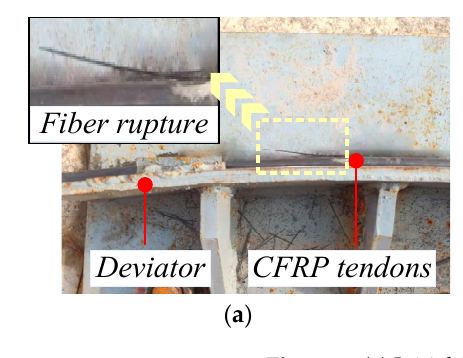
Figure 9. ( a ) Initial failure test, ( b ) Ultimate failure test. Failure in CFRP tendon tests. The load-time curve for cases B-20 and BF-20 under single bending showed that two peaks existed on the curve, points a and b (Figure 10), representing the axial force at the tensile end, which corresponded to the initial and the ultimate failure states (Figure 9a,b, respectively). In addition, there was a difference between the axial force curves of the tensioned and fixed ends, and the BF-20 working condition demonstrated a larger gap than the B-20 working condition. This was because BF-20 had no buffer material and larger friction loss than B-20. However, the UBC results of the two sets of working conditions were similar and the same result was also obtained on the basis of comparisons among the working conditions of B-30 and BF30 and of B-40 and BF40. This verified that the bending angle parameter in Equation (7) of the calculation model was not the parameter that influ- enced the results. Thus, the bending angle and buffer material in the experimental research conditions were not deemed to be factors that affected the ultimate bending capacity.